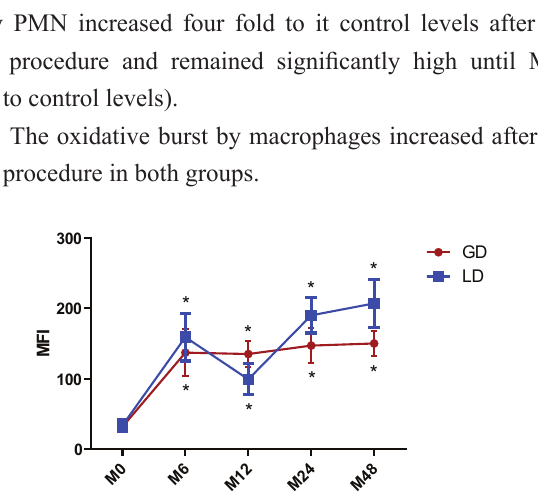
FIGURE 3 - Oxidative burst of PMN cells from synovial fluid observed at 0, 6, 12, 24 and 48 hours after arthroscopy. Gate analysis was set on PMN cells using forward and side scatter gating. Values represent mean fluorescence intensity (MFI) in gated cells. Data are represented as mean ± SD. *p<0.05 in comparison to M0.